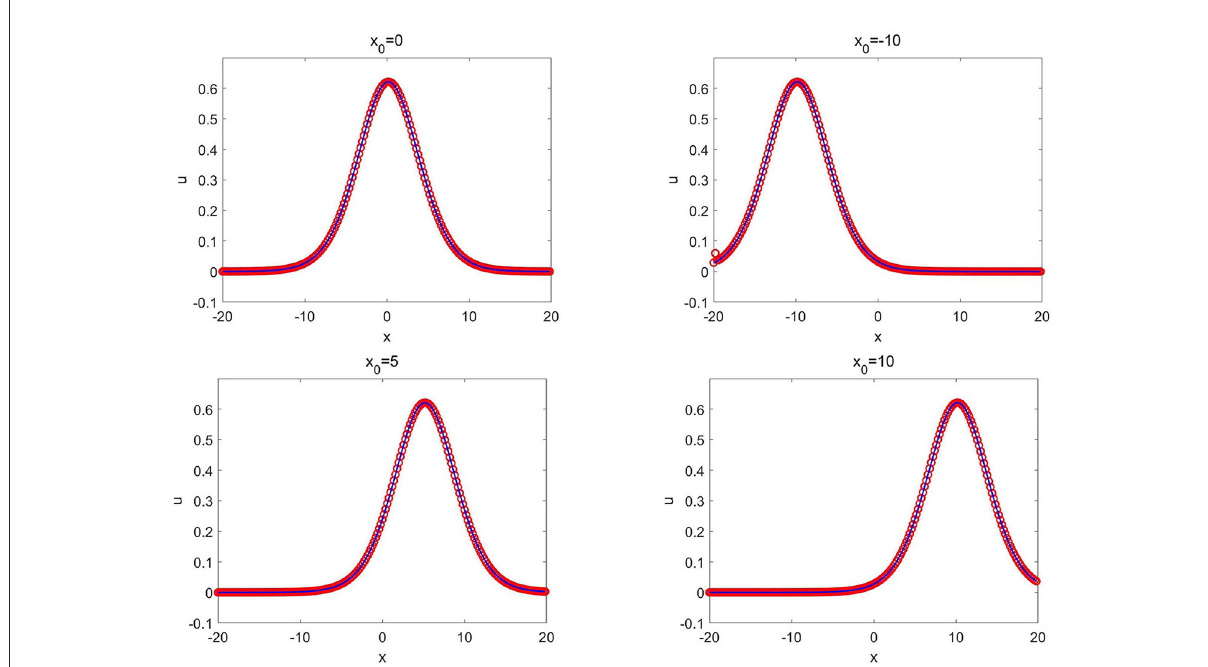
FIGURE8 Kawahara equation of Example 3.6: the CANN solution (red circles) and the exact solution (solid blue lines) at T